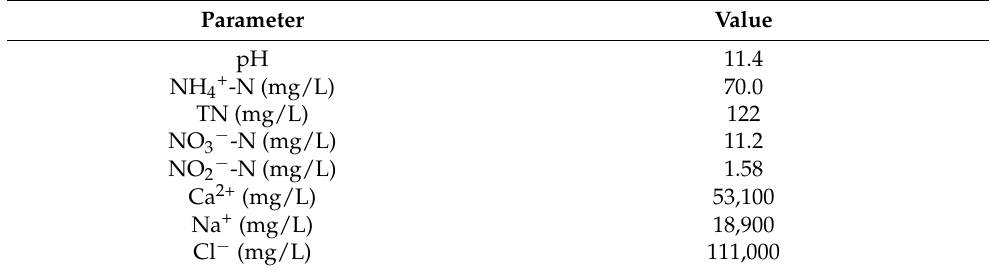
Table 1. Main water parameters of the spent caustic